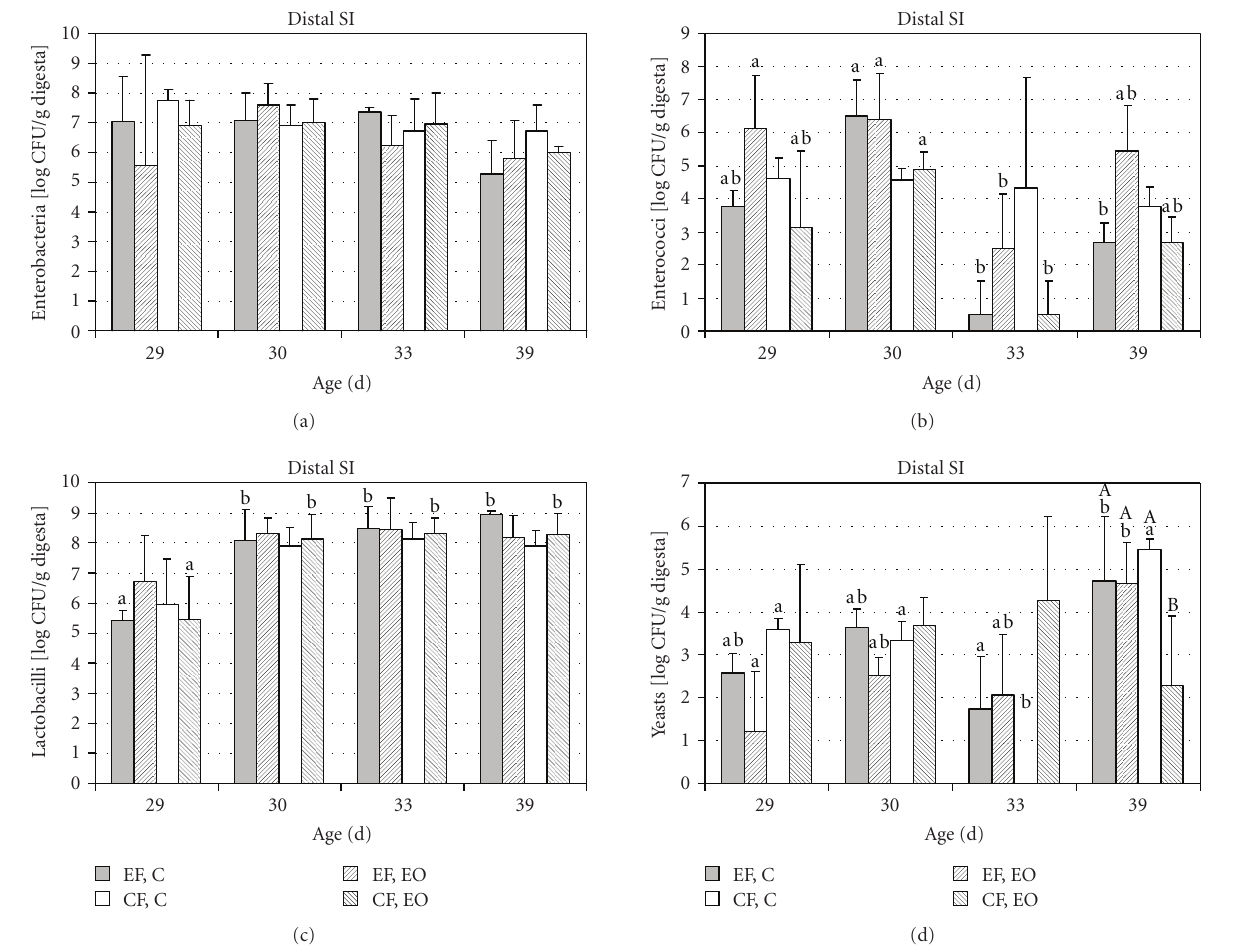
Figure 2: Bacterial groups and yeasts (log CFU/g) cultivated from distal small intestinal digesta collected at 29, 30 , 33, and 39 day of age from piglets fed after weaning (at 28 days) a starter diet (C) with 0.04% of essential oils mixture containing limonene, pinene and eugenol. The piglets were reared either at an experimental (EF) of commercial farm (CF). The significant di ff erences ( P < . 05) between days within one group are marked with di ff erent small letters (a, b), and the di ff erences between groups on one day are marked with capital letters (A, B). For clarity, only columns that di ff er are